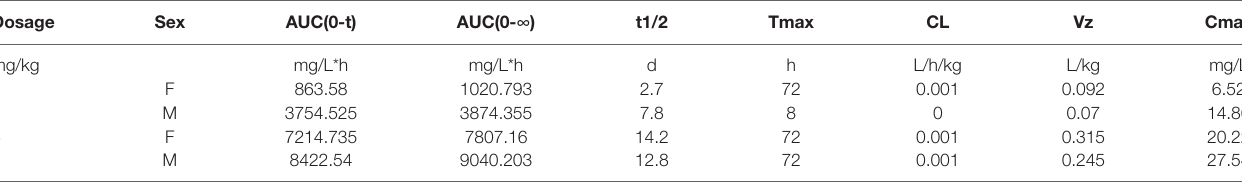
AUC(0- ∞ ) = area under the plasma concentration-time curve extrapolated to in fi nity; AUC(0-t) = area under the plasma concentration-time curve from time zero to the time of the last quanti fi able concentration; t1/2 = plasma elimination half-life; Tmax = time when Cmax was reached; Cmax = maximum observed serum concentration; Vz = apparent volume of distribution during terminal elimination phase; CL = serum